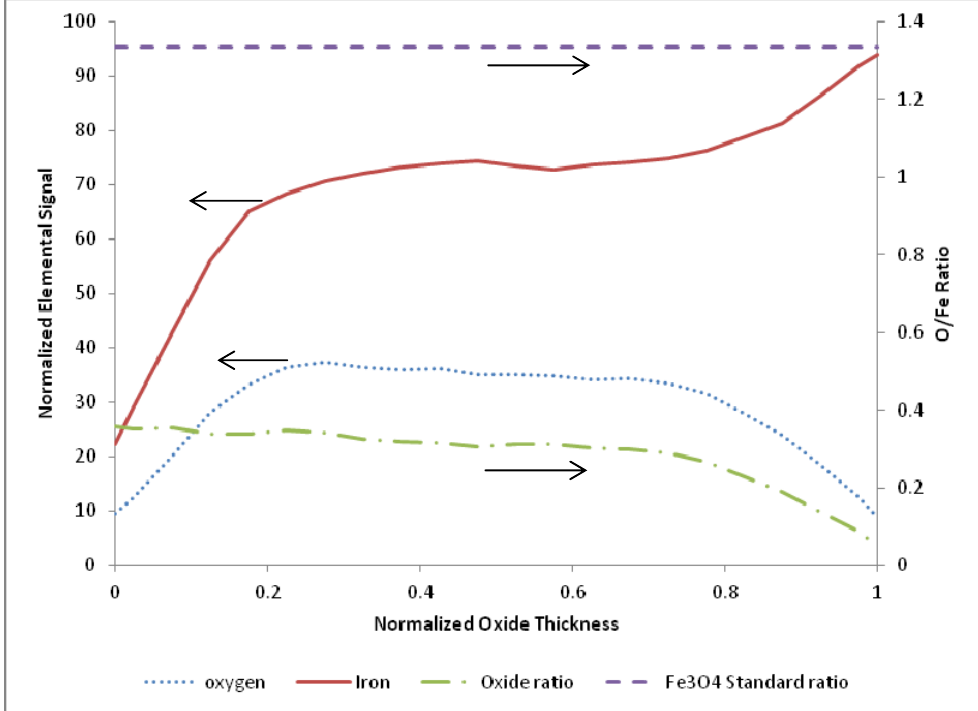
Figure 7. Average of 10 EDS line scans through the oxide layer from samples terminated after ending on a reduction step, with 0 corresponding to the outer edge of the oxide layer and 1 corresponding to the iron-iron oxide